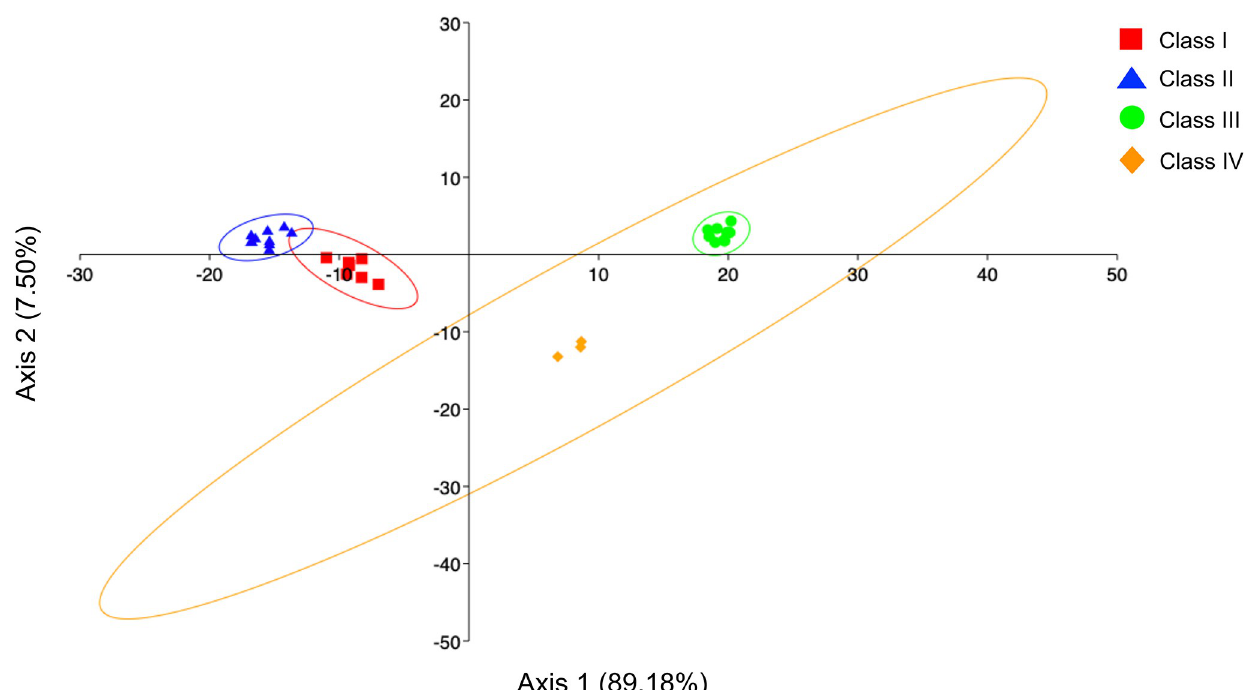
Fig 9. Linear Discriminant Analysis (LDA) computed between the size class analyzed, calculated on Wavelet Fourier descriptors obtained by the left side of lapilli . Ellipses includes 95% confidence interval.